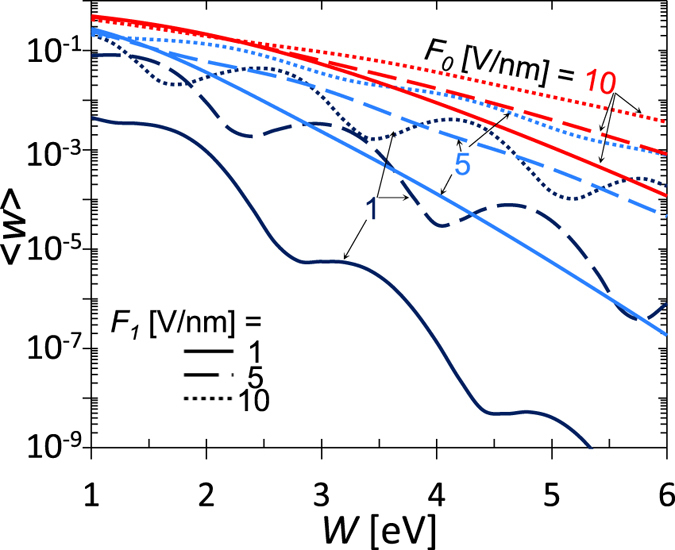
Effects of the barrier height (or work function) W on the emission current density .For the laser electric field F1 = 1, 5, and 10 V/nm, the corresponding laser intensity I [W/cm2] = 1.33 × 1011 × (F1[V/nm])2 is 1.33 × 1011, 3.33 × 1012, and 1.33 × 1013 W/cm2, respectively.